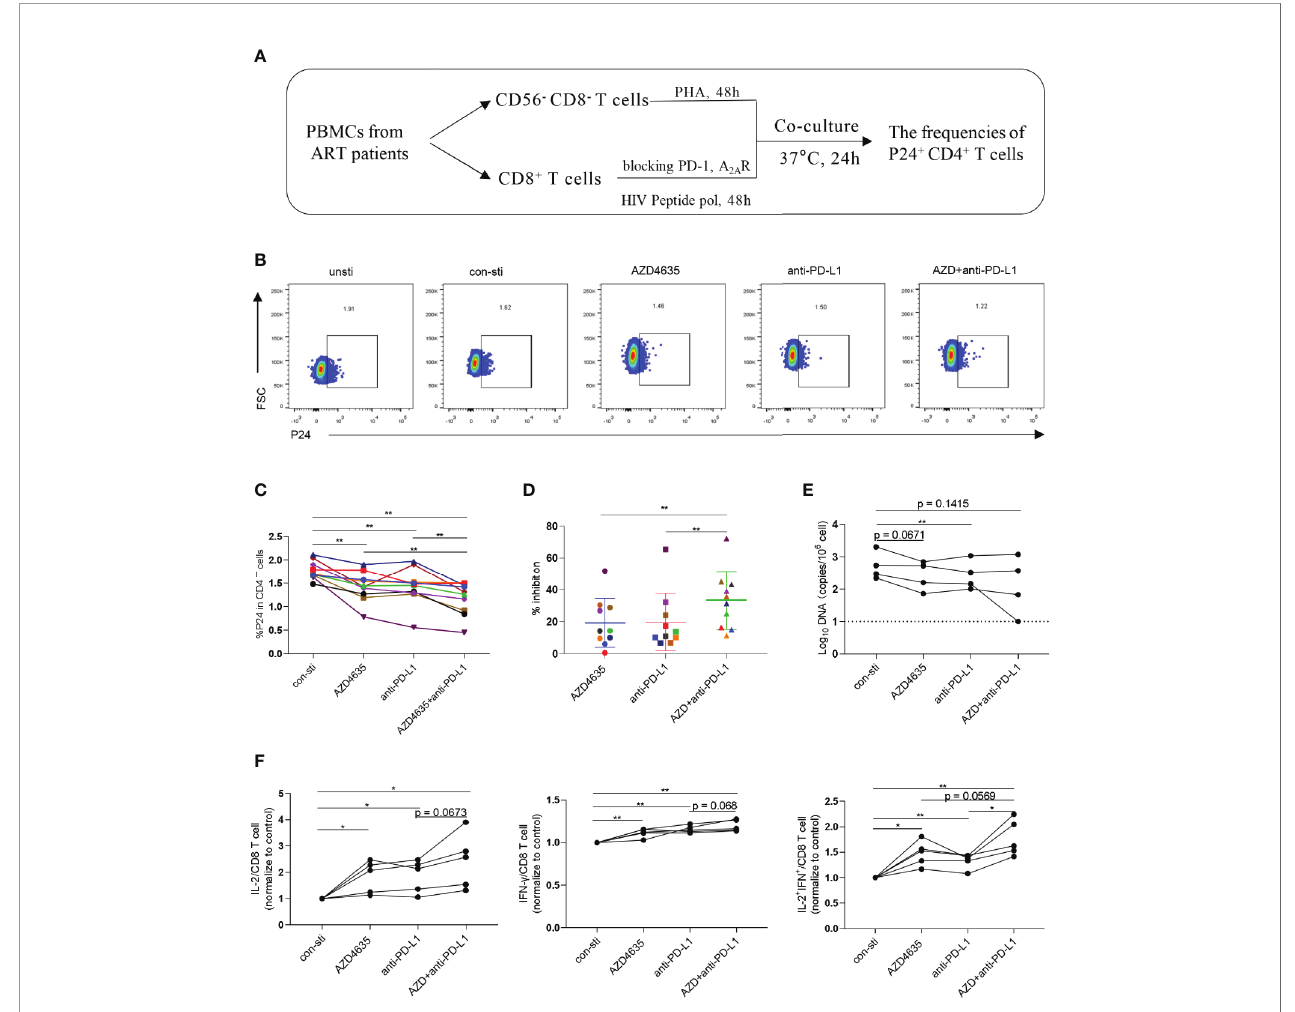
FIGURE 4 | Combined targeting of the adenosine and PD-1 pathways promotes CD8 + T-cell-mediated viral inhibition. (A) Schematic of ex vivo killing assay. (B) Representative fl ow cytometry data showing p24 expression in CD4 + T cells after the different treatments with PBMCs from ARTs. (C) The frequencies of p24 + CD4 + T cells after the different treatments. (D) The inhibitory ef fi ciencies were calculated in the different treatment groups. % inhibition = (Control group - Treatment group)/Control group. (E) HIV DNA levels after the different treatments with PBMCs from ARTs. (F) The secretion of IL-2, IFN- g and IL-2 plus IFN- g by the CD8 + T cell populations were analyzed by fl ow cytometry. Representative fl ow cytometry data are shown in (F) and the normalize levels of intracellular IL-2 (left), IFN- g (middle) and IL-2 plus IFN- g (right) in CD8 + T cells were statistically analyzed. Statistical tests were performed using a paired t -test, *p < 0.05, **p <